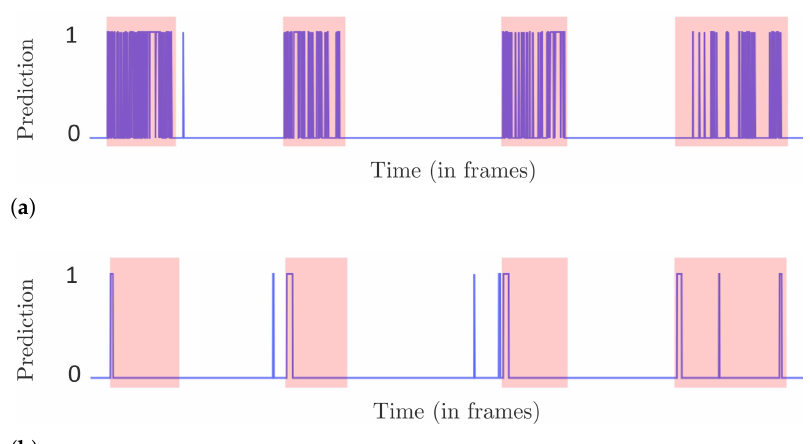
Figure 10. Example of per-frame predictions of two methods on a portion of video taken from i-LIDS test dataset. The intrusion intervals are shown in light red strips, the abscissa represents frames and ordinate shows prediction, where 1 signifies intrusion and 0 otherwise. ( a ) Nayak et al. [47]. ( b ) Lohani et al. [6] with